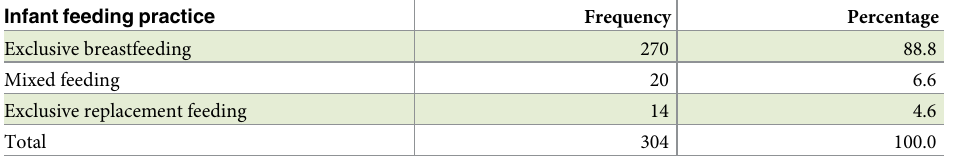
Table 3. Percentage of exclusive breastfeeding practice and other feeding practices of HIV positive women visiting public hospitals of Tigray region from July to October, 2016 (N =